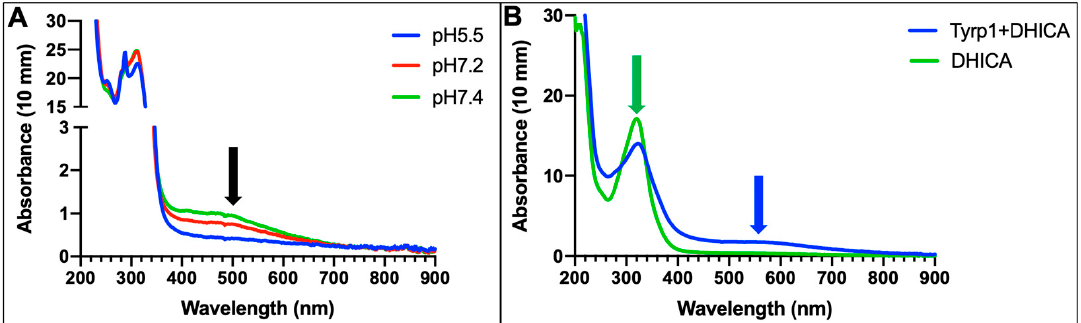
Figure 6. TYRP1 is Enzymatically Active. ( A ) TYRP1 was incubated for 4 hr with DHICA (1.5 mM), MBTH (1.5 mM), and TCEP (25 µM) at a pH of 5.5 (blue line), 7.2 (red line), and 7.4 (green line), which produces a peak at ~505 nm (black arrow) at 37 °C. ( B ) TYRP1 reacted with DHICA (blue line) and produces a broad peak representing the formation of a new product (IQCA) at ~560 nm (blue arrow) after 24 h incubation at 37 °C. The substrate decreases in absorbance at ~325 nm (green arrow) after 24 h incubation with TYRP1.